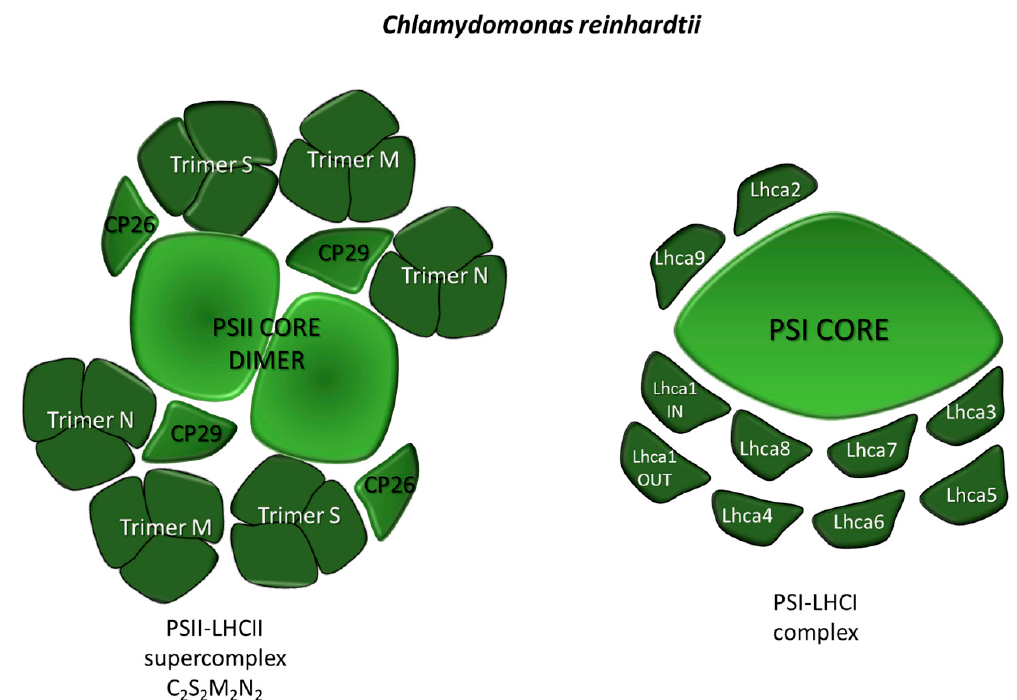
Figure 2. Supramolecular organization of PSII-LHCII and PSI-LHCI supercomplexes in the model alga Chlamydomonas reinhardtii . The schematic representations are based upon data from [33] for PSII-LHCII and from [36] for PSI-LHCI. The core complexes of both PSs are shown in light green while the antenna complexes are shown in dark green.